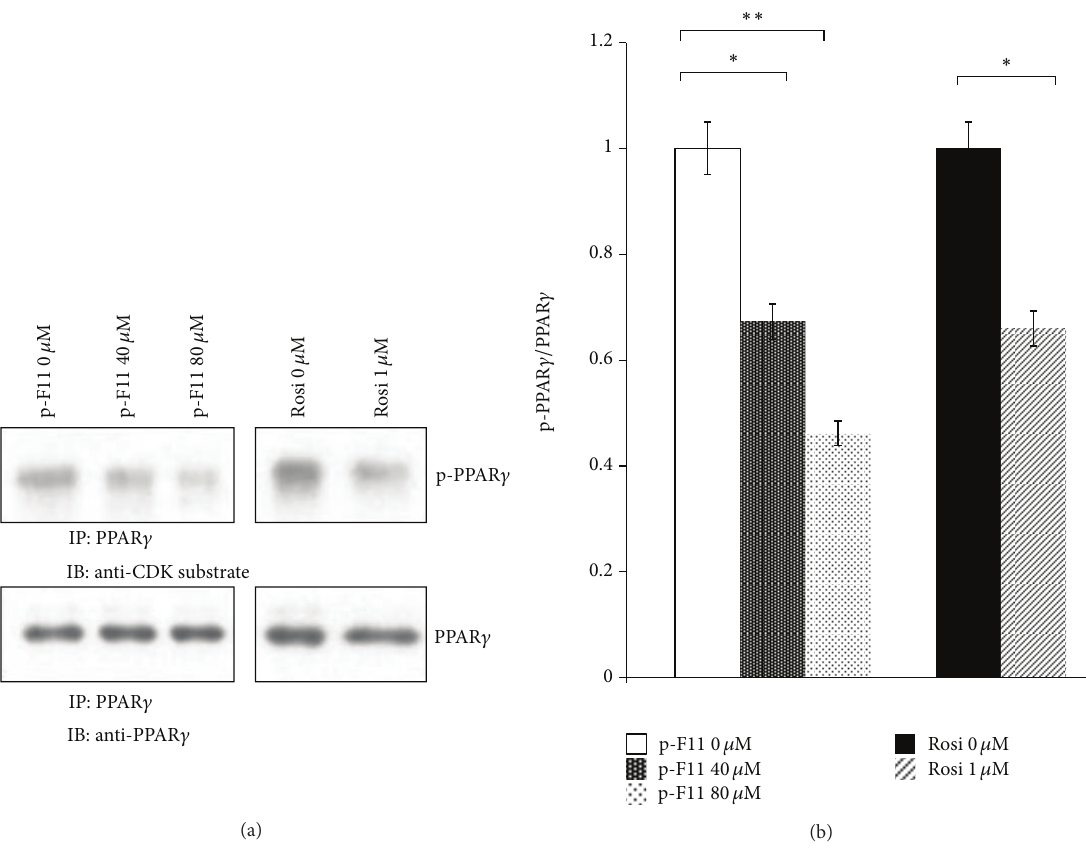
Figure 4: p-F11 inhibits PPAR 𝛾 phosphorylation at Ser-273. 3T3-L1 adipocytes were pretreated with TNF- 𝛼 , followed by treatment with p-F11 or Rosi for 1 hour. Phosphorylated PPAR 𝛾 at Ser-273 (p-PPAR 𝛾 ) was detected using anti-CDK substrate antibody after immunoprecipitation with anti-PPAR 𝛾 antibody. The amounts of p-PPAR 𝛾 and total PPAR 𝛾 were quantified and p-PPAR 𝛾 /PPAR 𝛾 ratio was presented as a percentage of the control (p-F11 0 𝜇 M or Rosi 0 𝜇